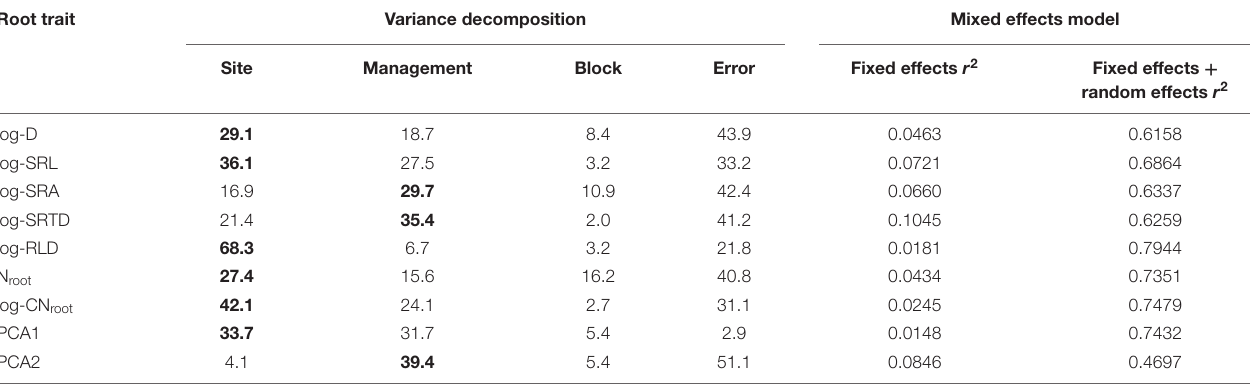
TABLE 4 | Sources of intraspecific variation in root traits of C . arabica . Root